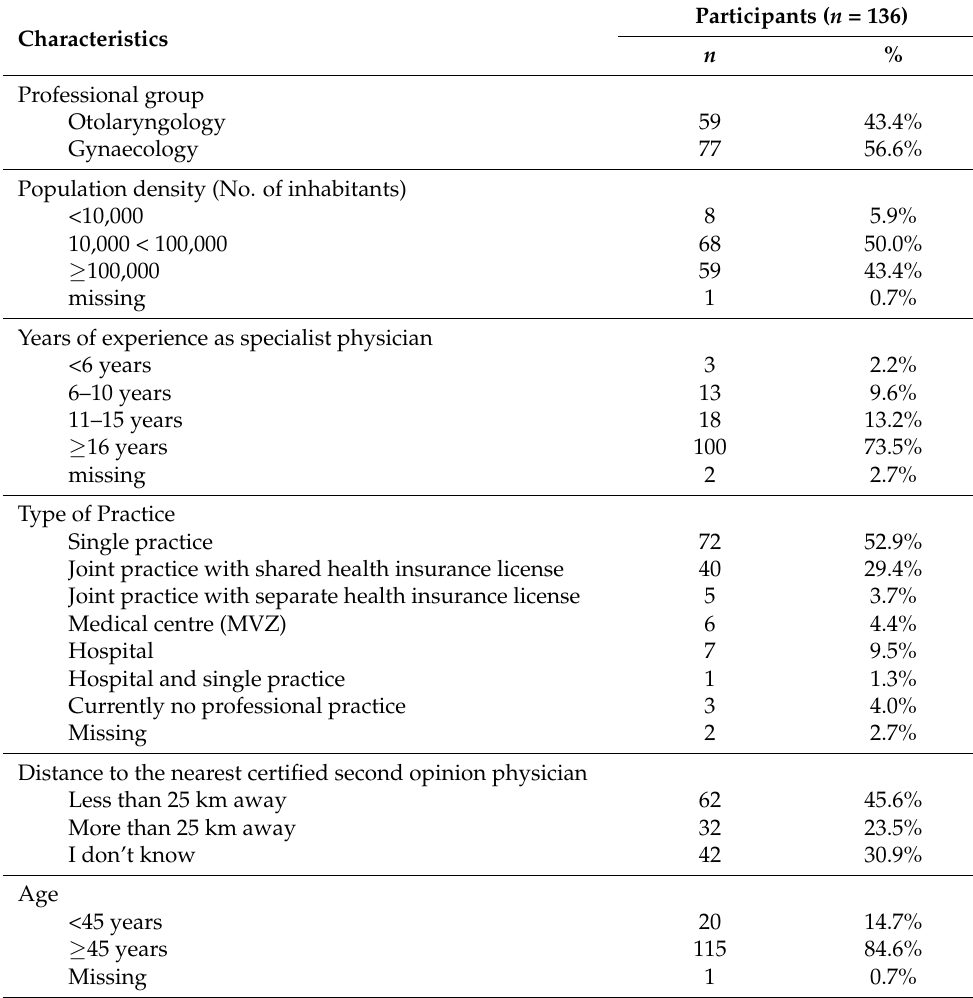
Table 1. Characteristics of 136 participants in the survey.